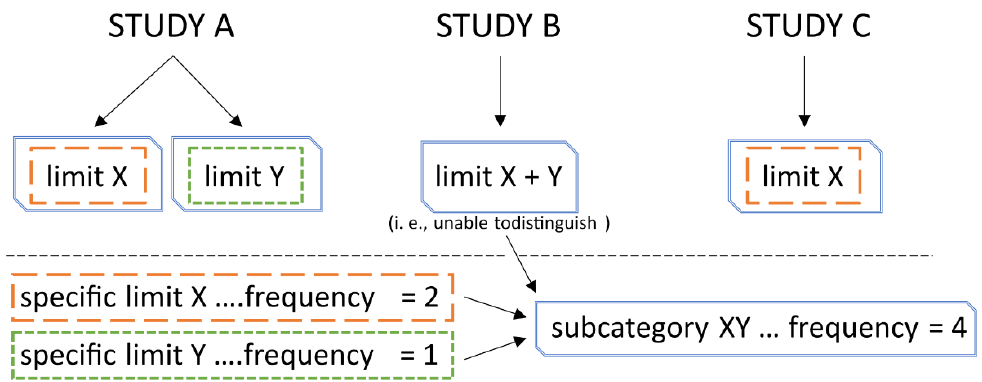
Figure 2. Calculation of the frequency of higher categories in the case of an unspecified